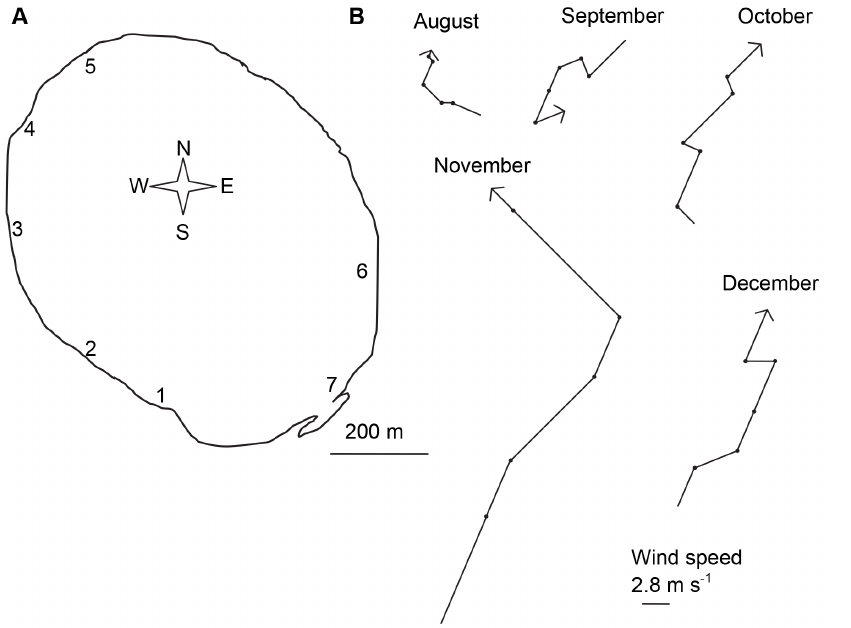
Figure 1. Study site and wind conditions. (A) Map of Lake Yangebup with sampling sites; (B) Wind speed and direction for the sampling days and the two antecedent days for each month. Wind measurements were taken at 9 am and 3 pm of each day, resulting in 4 measurements for each month, represented by a line with either a dot or an arrow in wind direction.